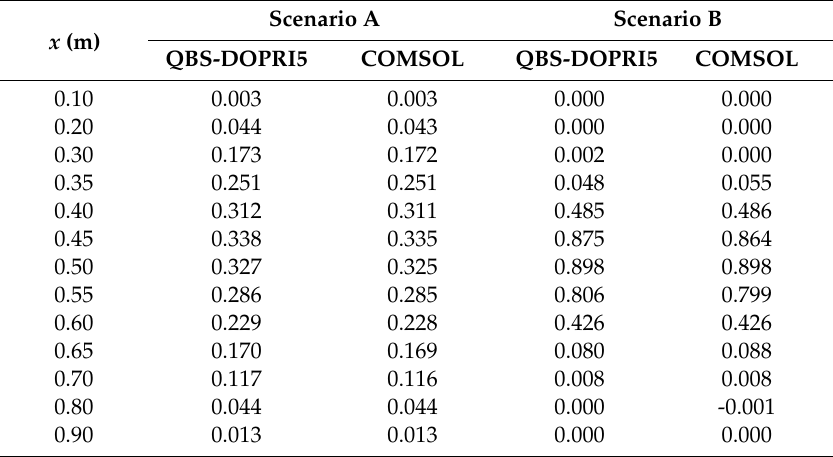
Table 9. QBS-DOPRI5 and COMSOL Multiphysics outflow results at di ff erent x coordinates.